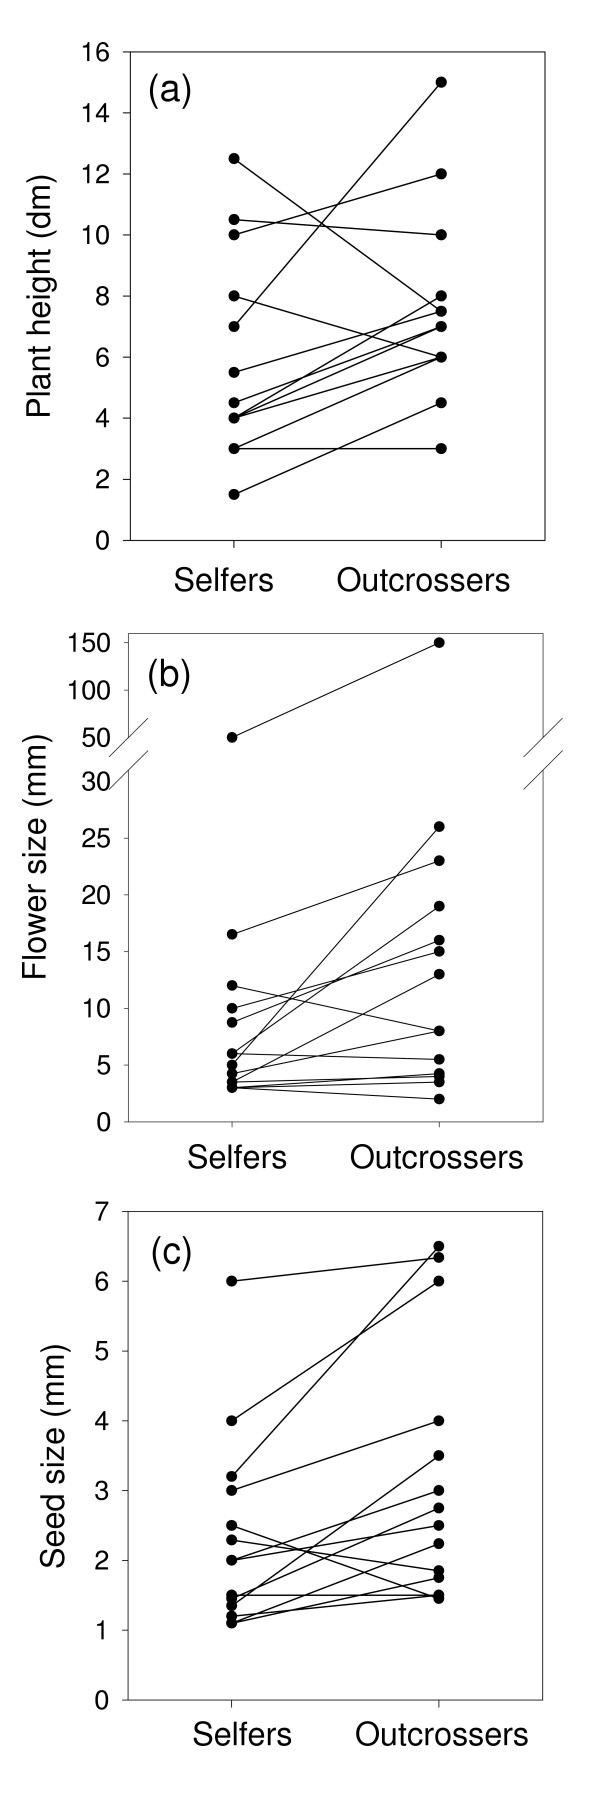
(a) Plant height contrasts for 13 selfing and outcrossing pairs (some points overlap), where each pair consists of the median value of the selfing and outcrossing species within one family. (b) Flower size contrasts for 14 selfing and outcrossing pairs. (c) Seed size constrasts between 14 selfing and outcrossing pairs. (See Appendix A for list of families and species).